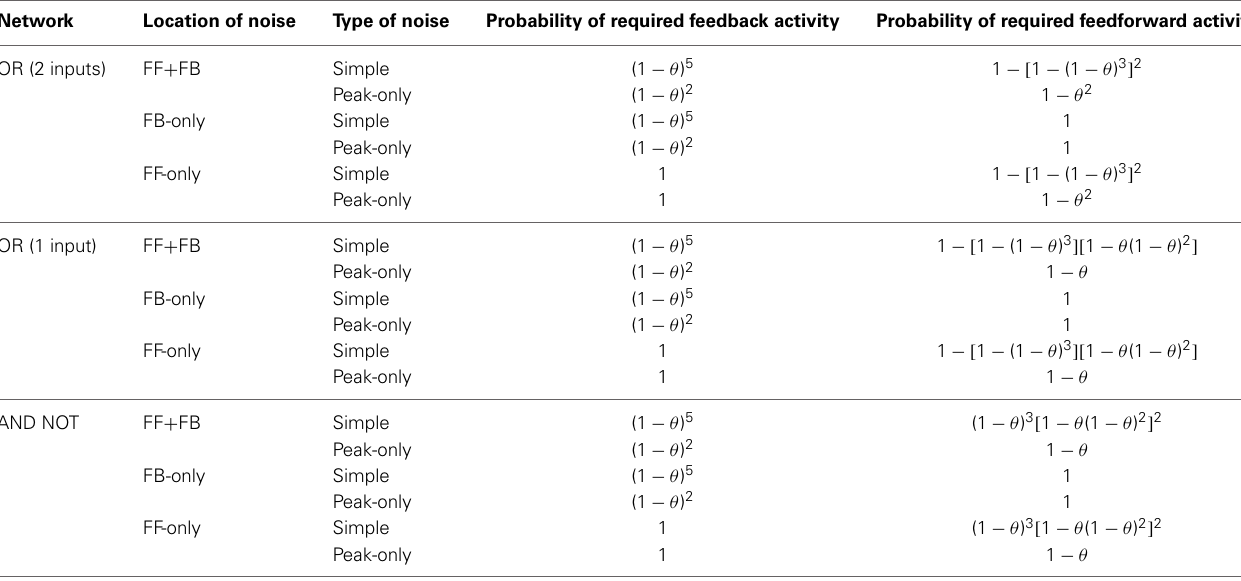
The networks considered are the “OR” network (with either one or both input units receiving feedforward activity) and the “AND NOT” network (with both input